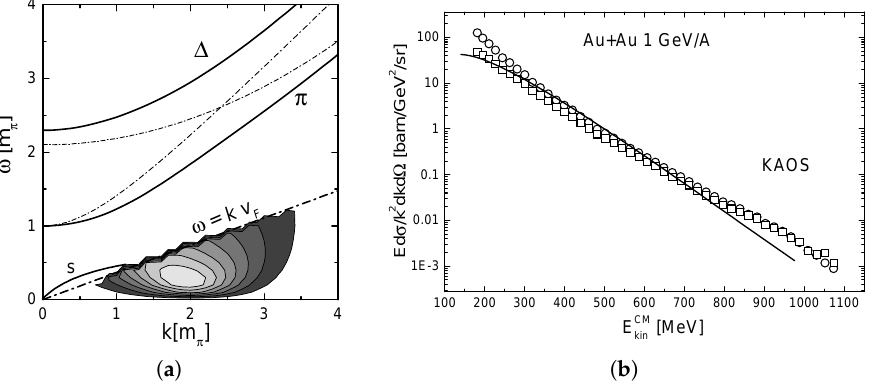
Figure 8. Figure from [49]. ( a ) pion spectrum in ISM at the nuclear saturation density. Dash-dotted lines are the vacuum spectra of pions and ∆ . Solid lines show quasiparticle branches of pion excitations in medium provided one neglects effects of the particle widths. The contour plot depicts the spectral density of virtual pions; ( b ) invariant differential cross section of pion production in Au+Au collisions with energy 1 GeV per nucleon as a function of the pion kinetic energy in the center-of-mass system in comparison with experimental data [50] (squares stand for π + mesons and circles for π −